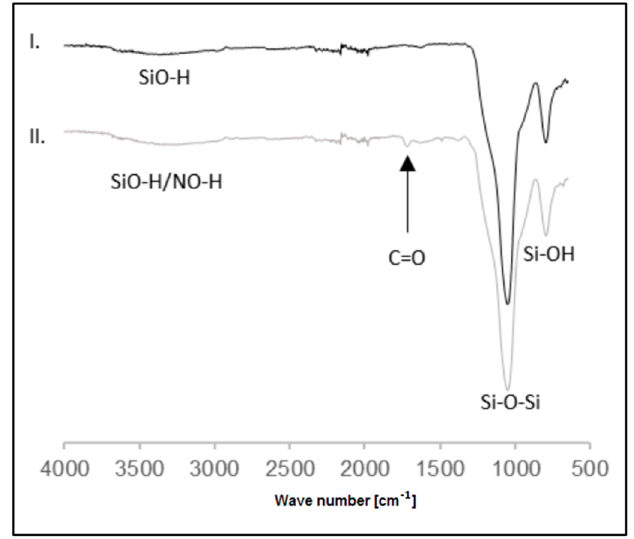
Figure 4. FT-IR spectra of I. SiCl and II. SiOCONHPI.